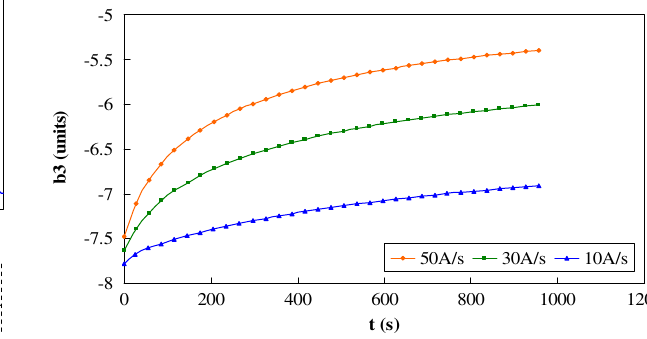
FIG. 3. (Color) MB2598 aperture 2 b 3 decay for standard mea- surement LHC cycles with different precycle ramp